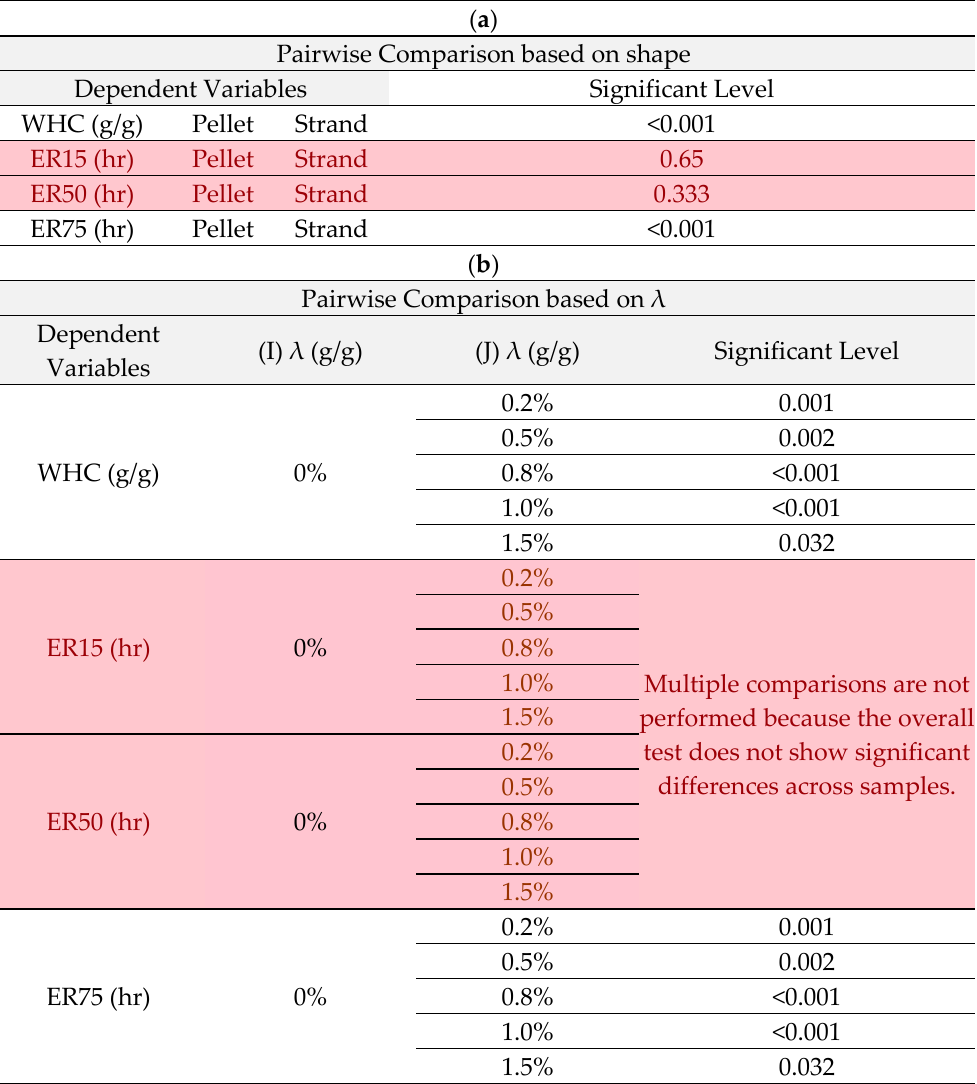
Table 2. ( a ) Pairwise comparison of WHC and ER of strands-pellets experiments once shape (type) of MP was a factor. We found statistically significant differences for each WHC and ER75. ( b ) Pairwise comparisons of contaminated samples with control samples, λ (g/g) = 0, once λ was considered as a factor. There were statistically significant differences for each WHC and ER75. In both tables, the significance level was considered as α = 0.05.